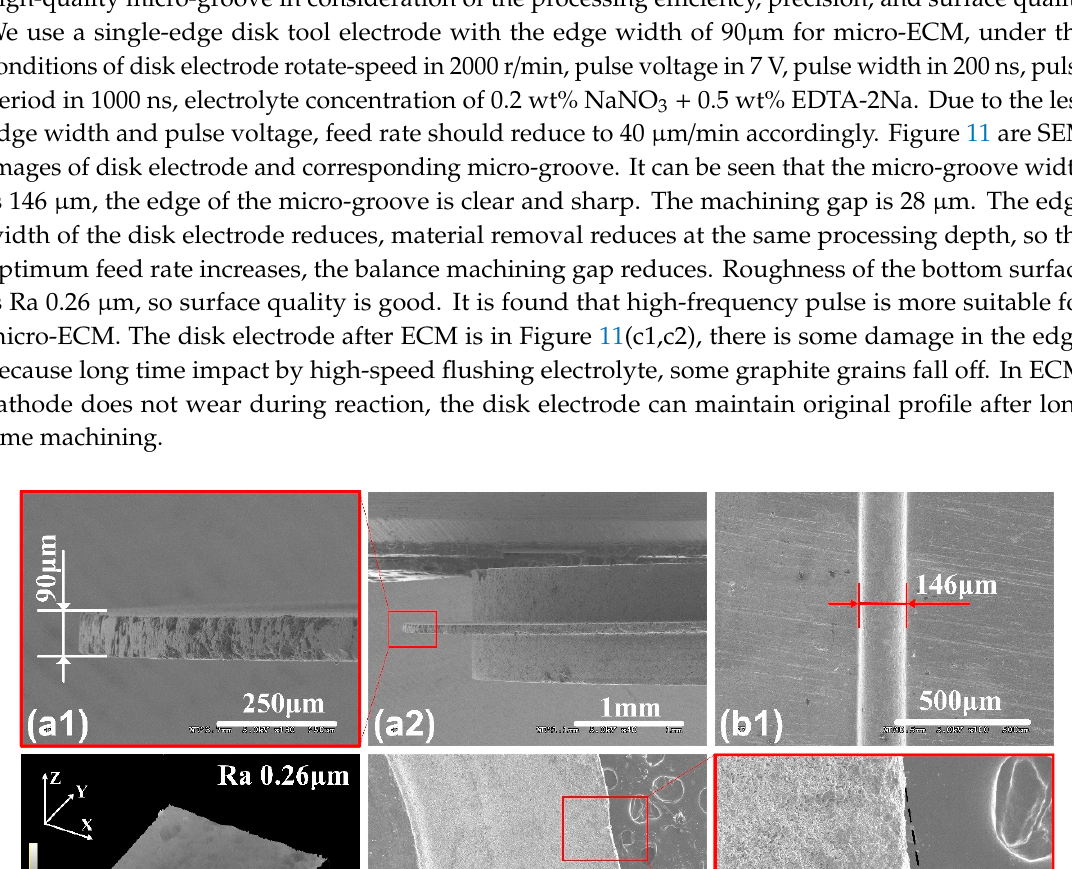
Figure 10. ( a1 – a3 ) SEM images of the micro-groove profiles with the pulse width of 200 ns, 500 ns and 1000 ns. ( b1 – b3 ) SEM images of the surface quality with corresponding pulse width.